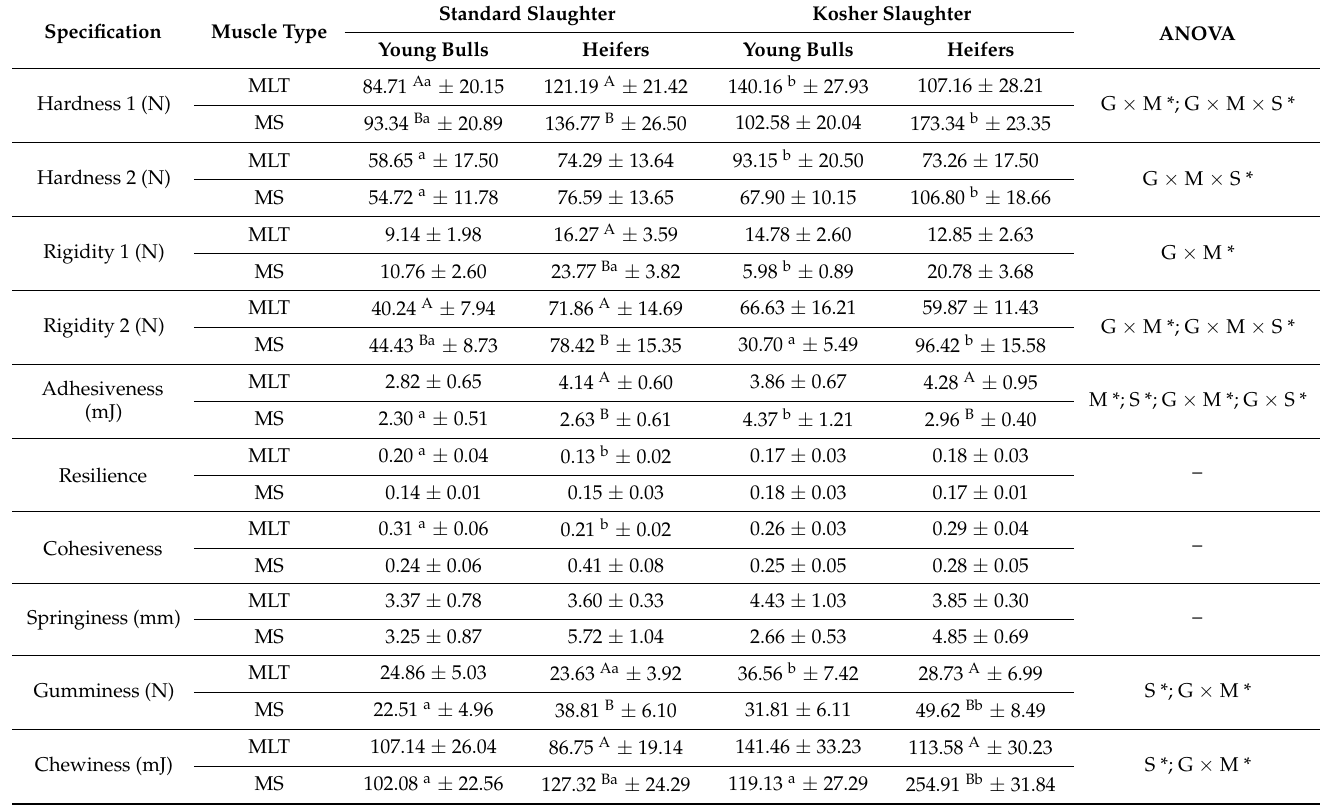
Table 2. Beef texture parameters ( x ± SE) depending on slaughter type, muscle type, and gender of